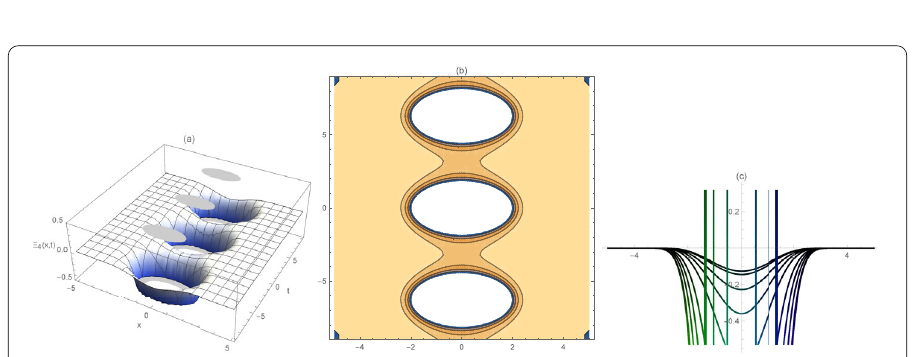
Figure 1 Solitary wave of the Cahn–Allen equation by using Eq. (12) in three- ( a ), two- ( c ) dimensional and contour plot ( b ), when [ σ = 1, α = 2, β = 3], which shows the structure of the dynamics for phase separation in Fe – Cr – X ( X = Mo , Cu ) ternary alloys